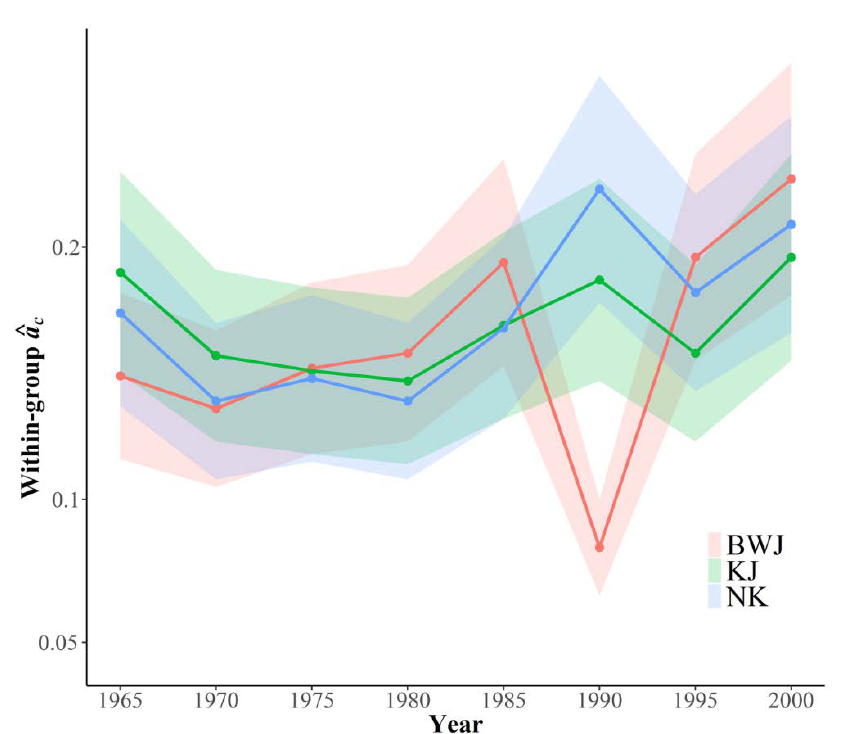
Table 2. Summary of linear mixed-effects models for long-term trends of log-transformed BAI residuals (log BAI residuals) for the periods 1951–1984 and 1985–2017 for three study sites (BWJ, KJ, NK) in Thailand. Linear mixed-effects models were built for each period and each site, with log BAI residuals as dependent variable, year as fixed factor and individual tree as random factor. Significance at p < 0.05 and p < 0.01 levels are in italic and bold respectively. AIC: Akaike’s Information Criterion.